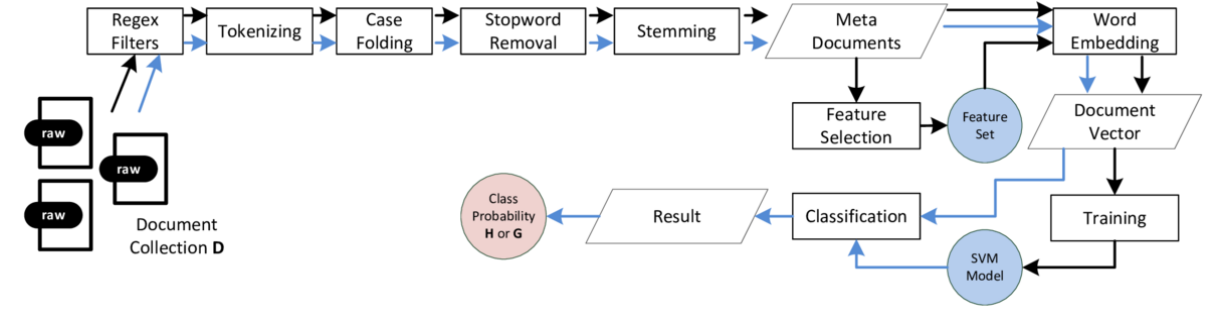
Figure 5. Workflow of an support vector machine–based text classification system: black lines indicate the training process; blue lines indicate the classification process; slanted boxes represent data; rectangular boxes represent computational